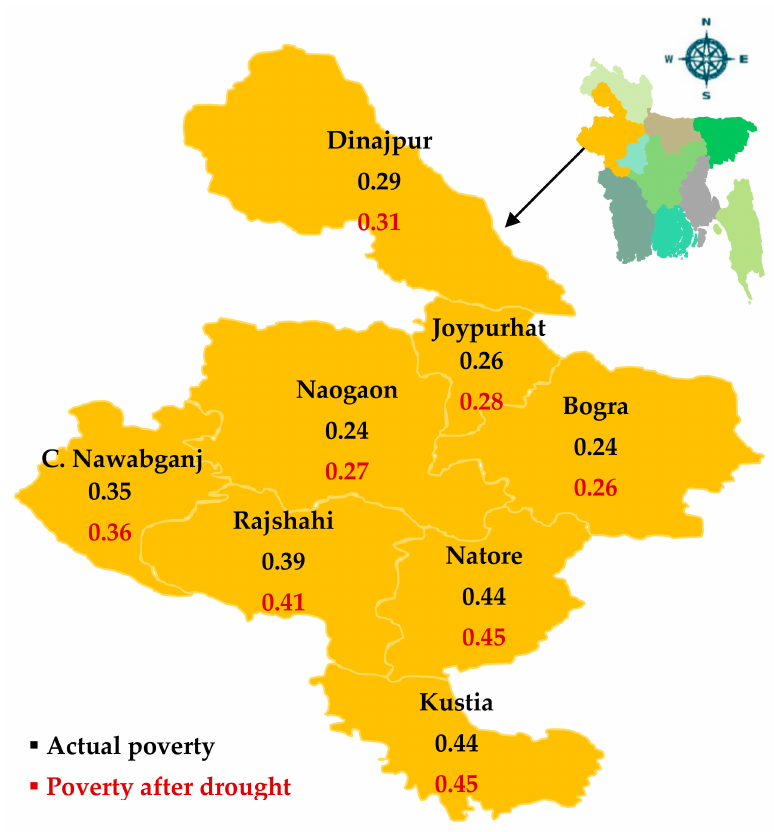
Figure 13. Changing poverty rates caused by drought in northwestern